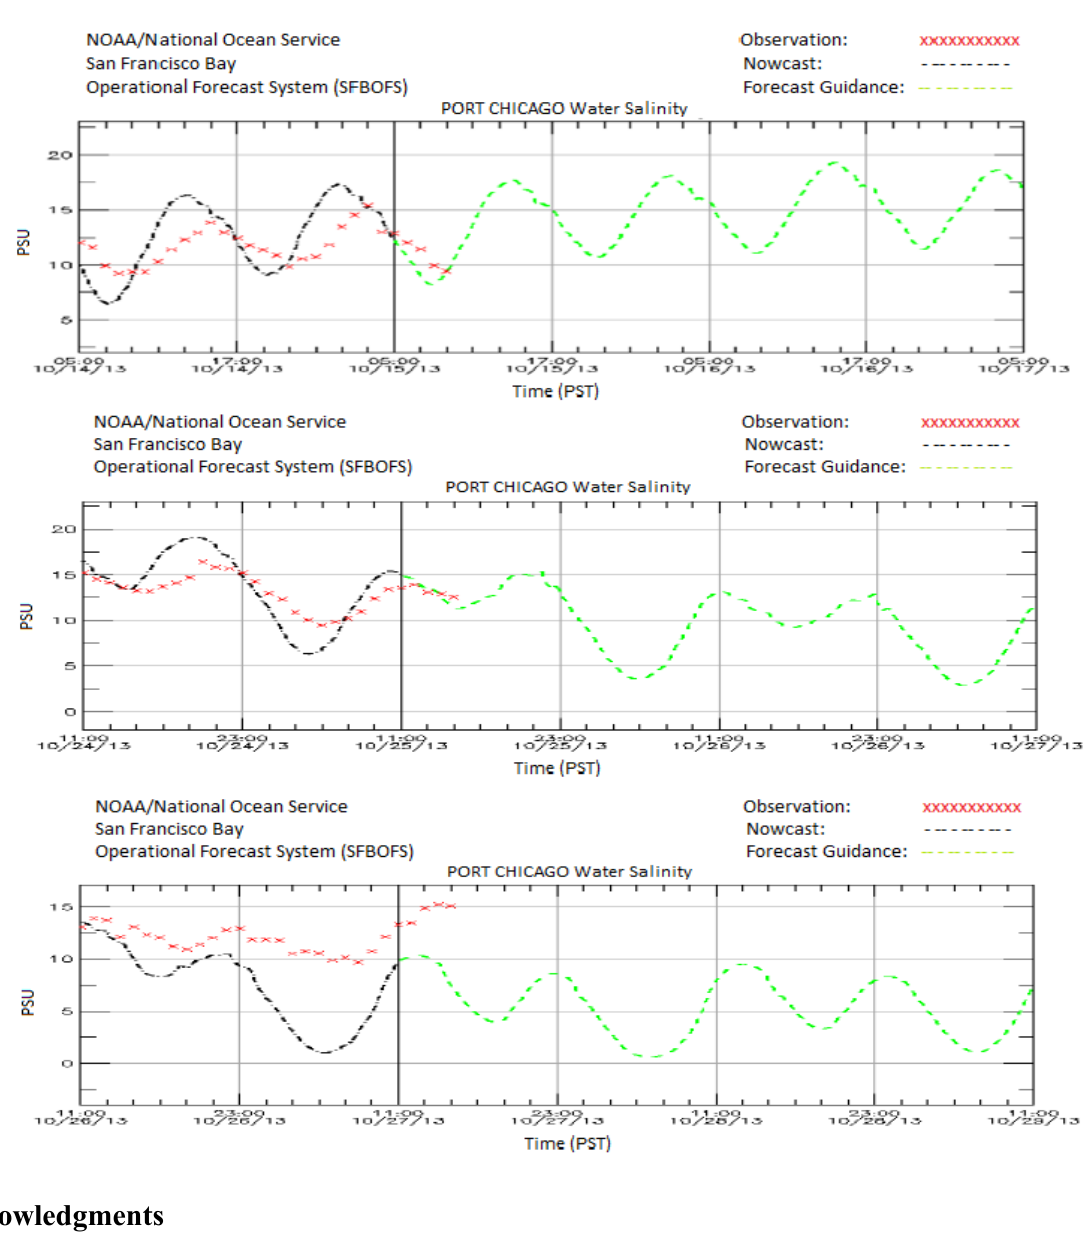
Figure 13. Modeled salinity strays away from observation with